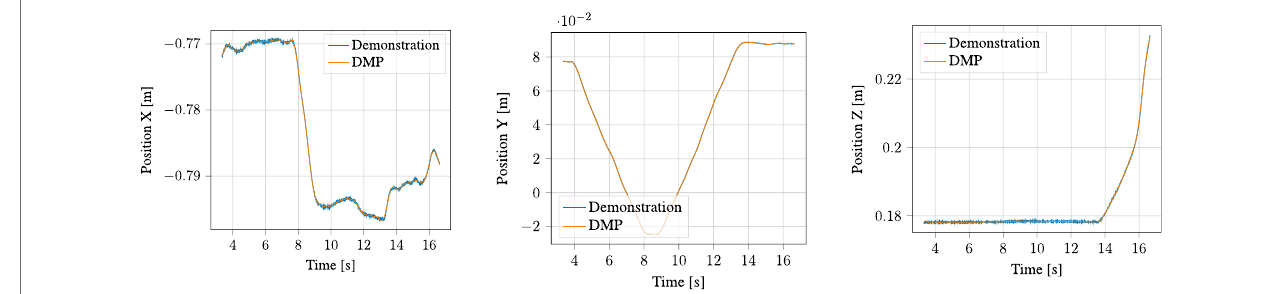
FIGURE 12 | Demonstrated position and corresponding Position DMP for the process motion.